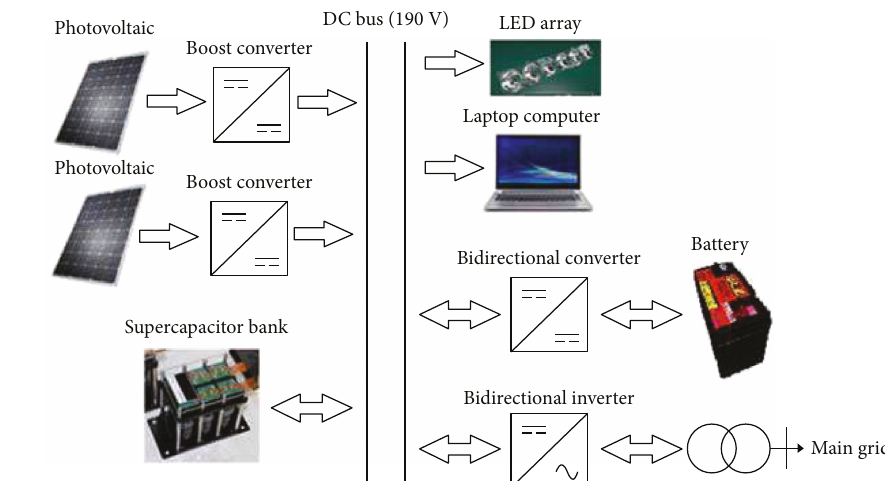
Figure 1: General scheme of the proposed DC microgrid.